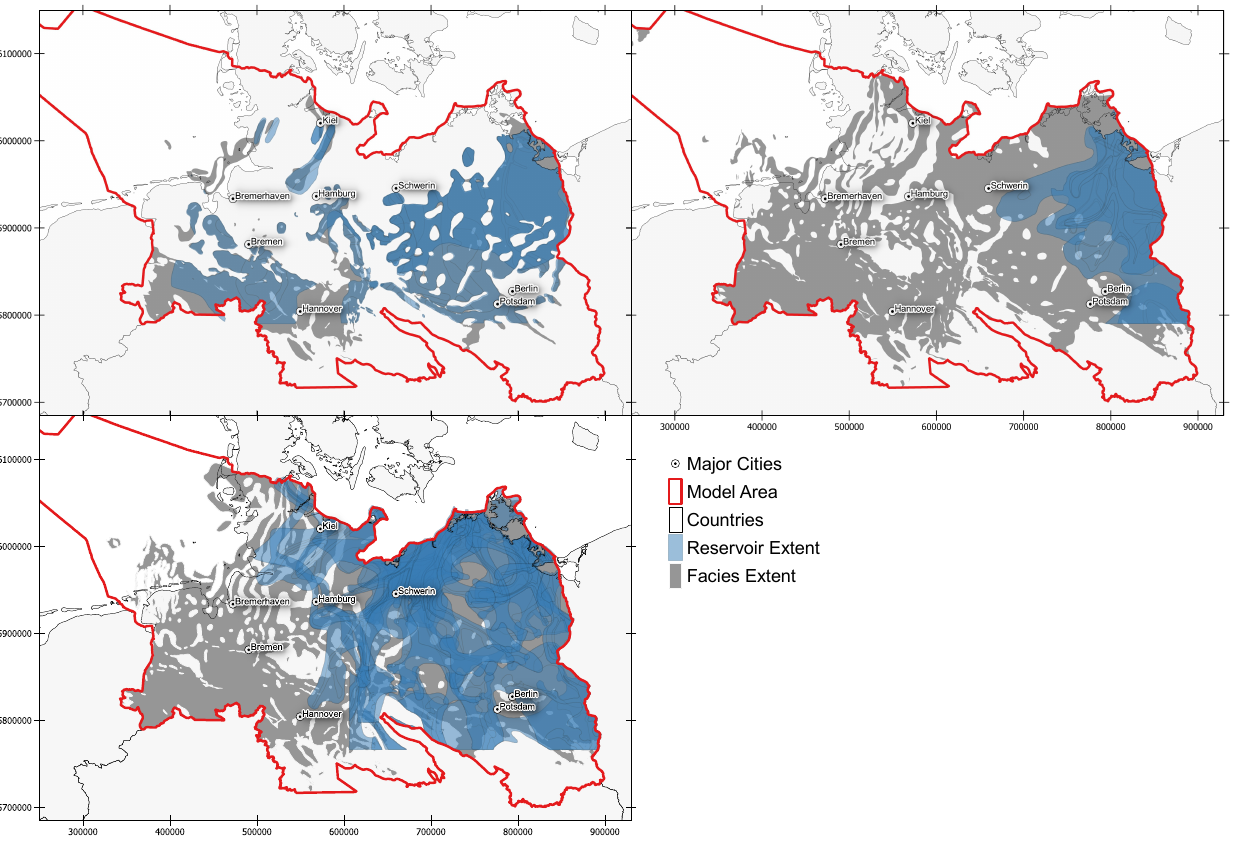
Figure A2. Comparison of lateral extent of reservoir units and facies contained therein according to [31] and Sandsteinfazies (GeoPoNDD [30]): ( a ) Middle Jurassic in gray and Upper Aalen and Upper Bajocian in blue; ( b ) Lower Jurassic in blue and Upper and Lower Toarcian in blue; ( c ) Upper Keuper in gray and Upper Exter, Lower Exter II, Lower Exter III, Upper Schilfsandstein, and Lower Schilfsandstein in blue. Coordinates are in UTM Zone